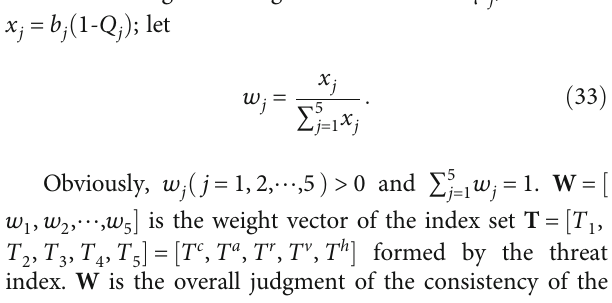
Step 2. “ Blindness ” analysis of “ typical ranking ”